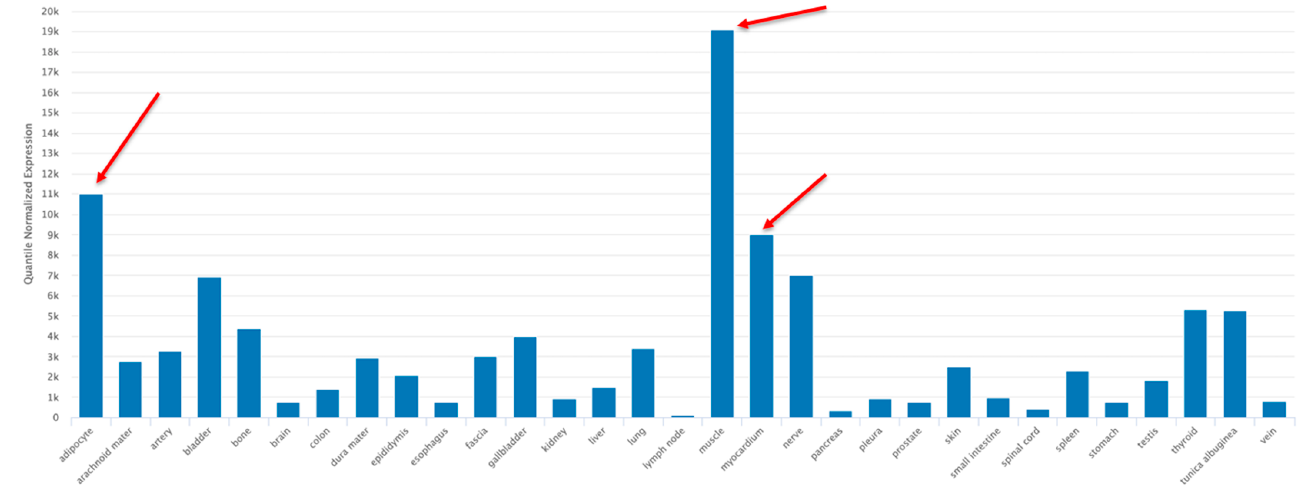
Figure 5. Tissue/organ distribution of miR-22-3p using the TissueAtlas2 program (https://www.ccb.uni-saarland.de/tissueatlas2 (accessed on 20 February 2023) [58], an Open Access article distributed under the terms of the Creative Commons Attribution-NonCommercial License (https://creativecommons.org/licenses/by-nc/4.0/). Adipocyte, myocardium and skeletal muscle samples are identi fi ed by red arrows.